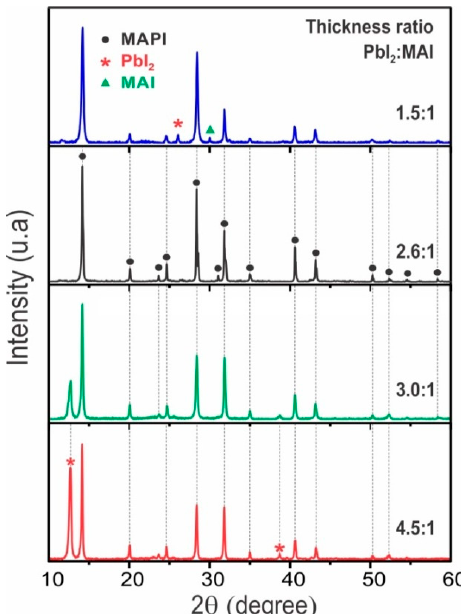
Figure 2. X-ray diffraction spectra of MAPI films prepared varying the lead iodide (PbI 2 )/MAI Figure 2. X-ray di ff raction spectra of MAPI films prepared varying the lead iodide (PbI 2 ) / MAI thickness ratio. thickness ratio. Materials 2018 , 11 , x FOR PEER REVIEW